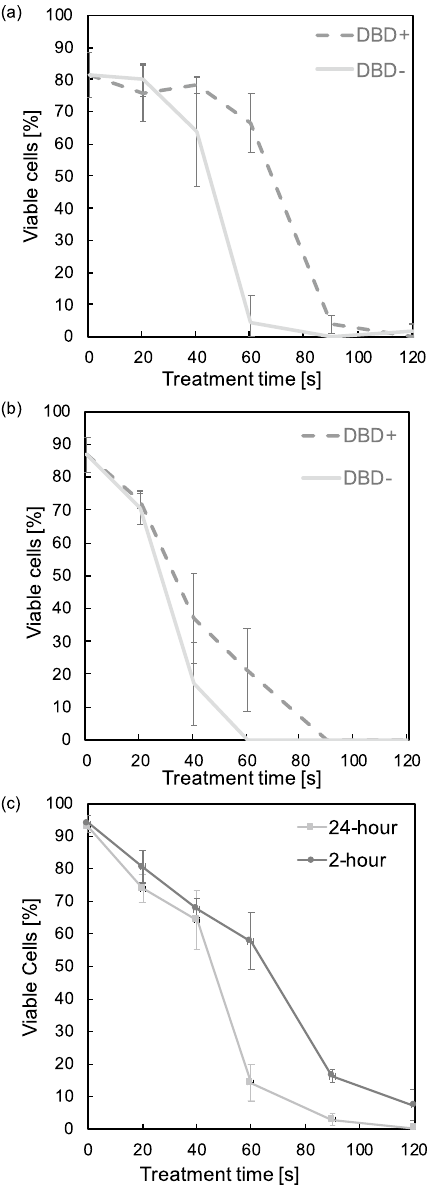
Figure 3. Cell viability versus exposure time ( a ) 2-h after treatment for Jurkat Cell, ( b ) 24-h after treatment for Jurkat cell, and ( c ) 2-h and 24-h after treatment for U937 Cells by ns-DBD compared to the negative control (0 exposure), (n =